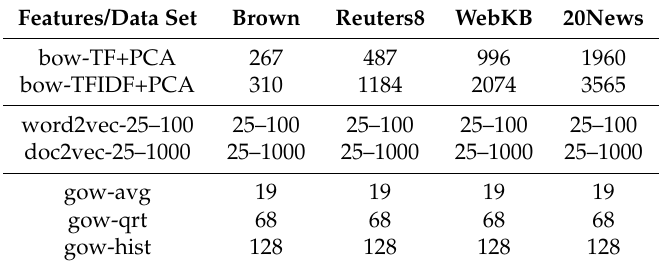
Table 2. Feature-space dimensionality for the 16 variants of the three document representation models and the four benchmark data